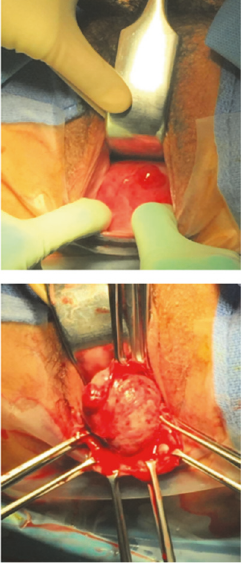
Figure 1: Lesion on exam under anesthesia and gross specimen during